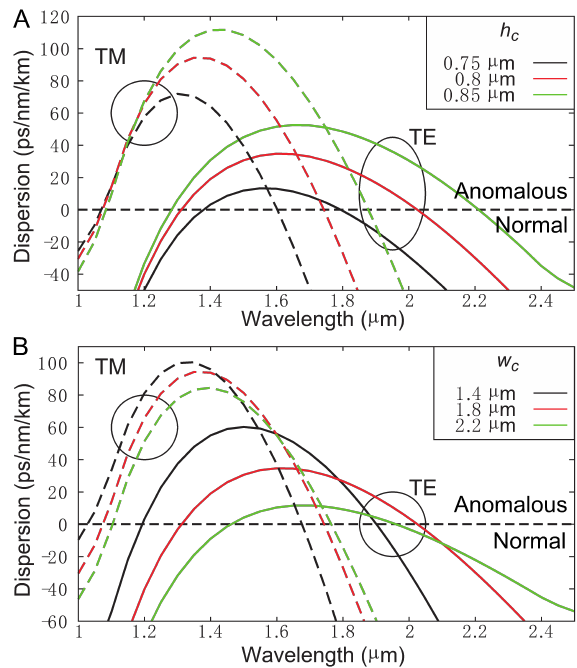
Figure 3: Dispersion engineering of Si 3 N 4 waveguide embedded in SiO 2 by tailoring the waveguide cross-section. w c and h c rep- resent the waveguide width and height, respectively. Simulated group velocity dispersion of the fundamental TE and TM modes when (A) w c = 1.8 µ m and h c = 0.75 µ m, 0.8 µ m, and 0.85 µ m; (B) h c = 0.8 µ m and w c = 1.4 µ m, 1.8 µ m, and 2.2 µ m. Adapted from Ref.